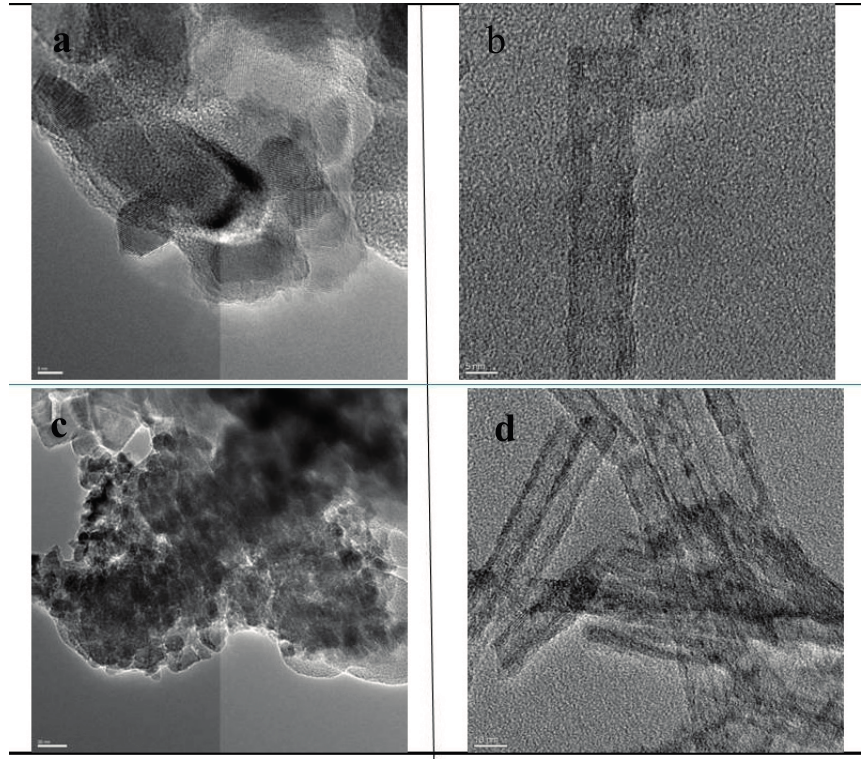
Figure 4. TEM images of the TiNT–O 2 -H 2 and the cTiNT-O 2 -H 2 : ( a ) cTiNT-O 2 -H 2 with a magnification scale of 20 nm; ( b ) TiNT with a magnification scale of 20 nm; ( c ) cTiNT-O 2 -H 2 with a magnification scale of 50 nm; ( d ) TiNT with a magnification scale of 50 nm.